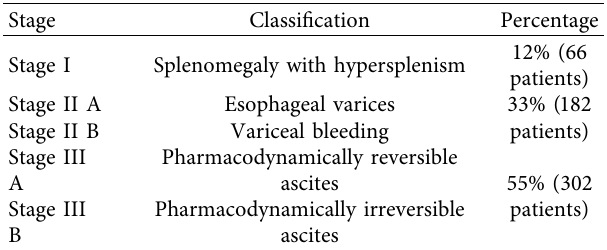
Table 1: Stages of